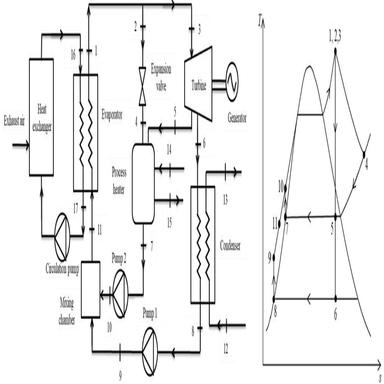
Schematic and T-s diagrams of the ORC-CHP system.